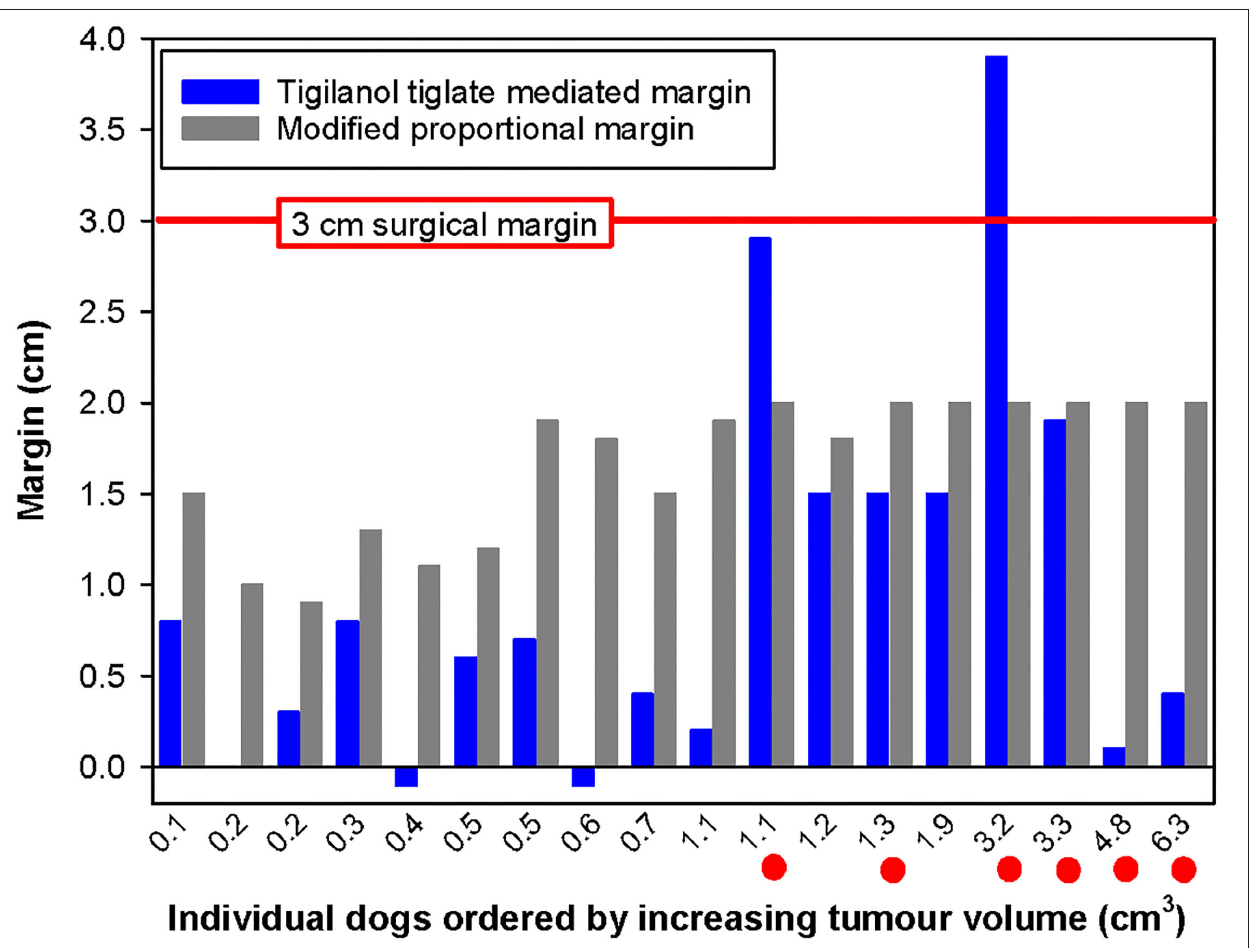
FIGURE 5 | Paired comparison of TT-mediated margins with modified proportional surgical margins organised by increasing tumour volume for each of the 18 dogs with MCTs on lower limbs (below the elbow and stifle) that were recurrence free 12 months after a single intratumoural treatment with TT. Note the horizontal red line, which represents the 3cm surgical margin, and the six red dots below the individual tumour volumes on the x-axis indicate cases illustrated in Figure 6